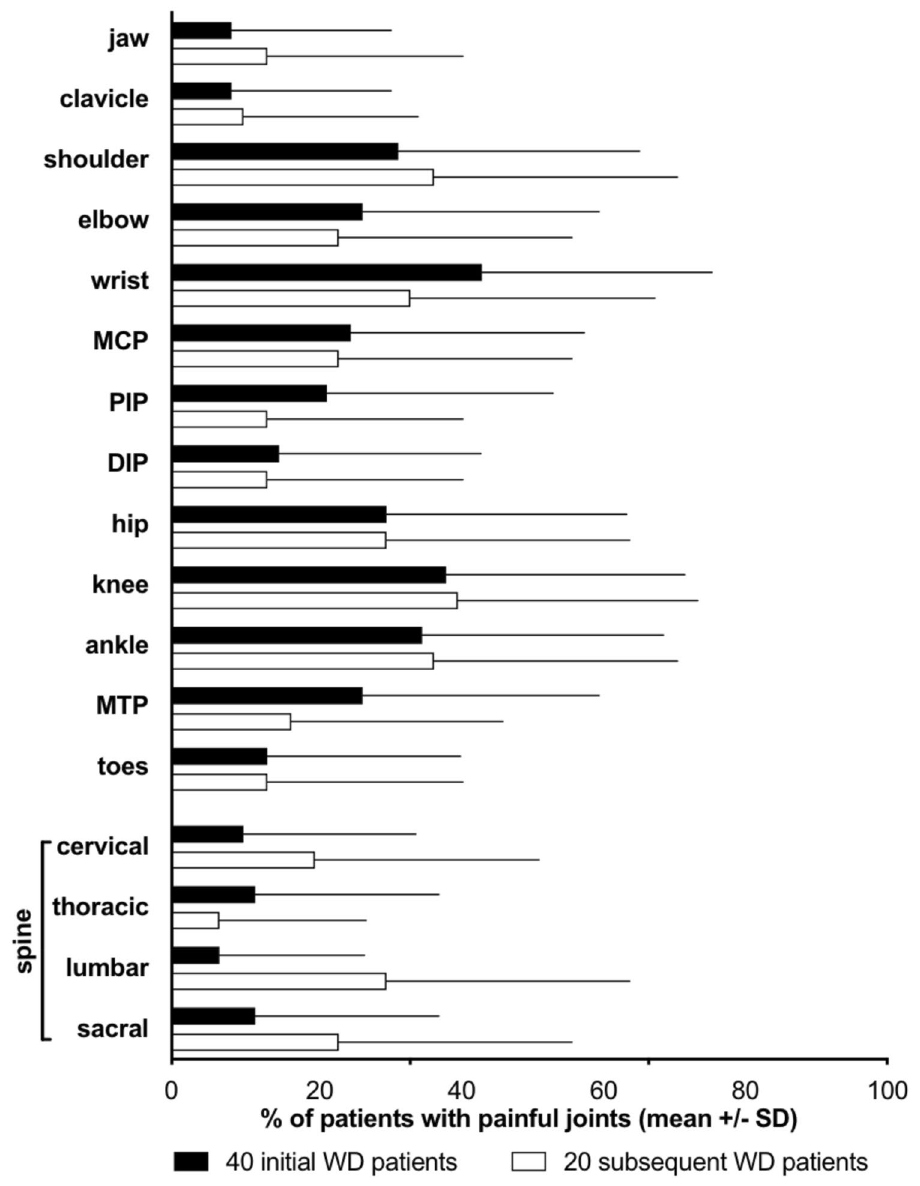
Figure 1. Percentage of Whipple’s disease patients with painful joints in the initial and subsequent series. PIP proximal interphalangeal joints, DIP distal interphalangeal joints, MCP metacarpo-phalangeal joints, MTP metatarsophalangeal joints.